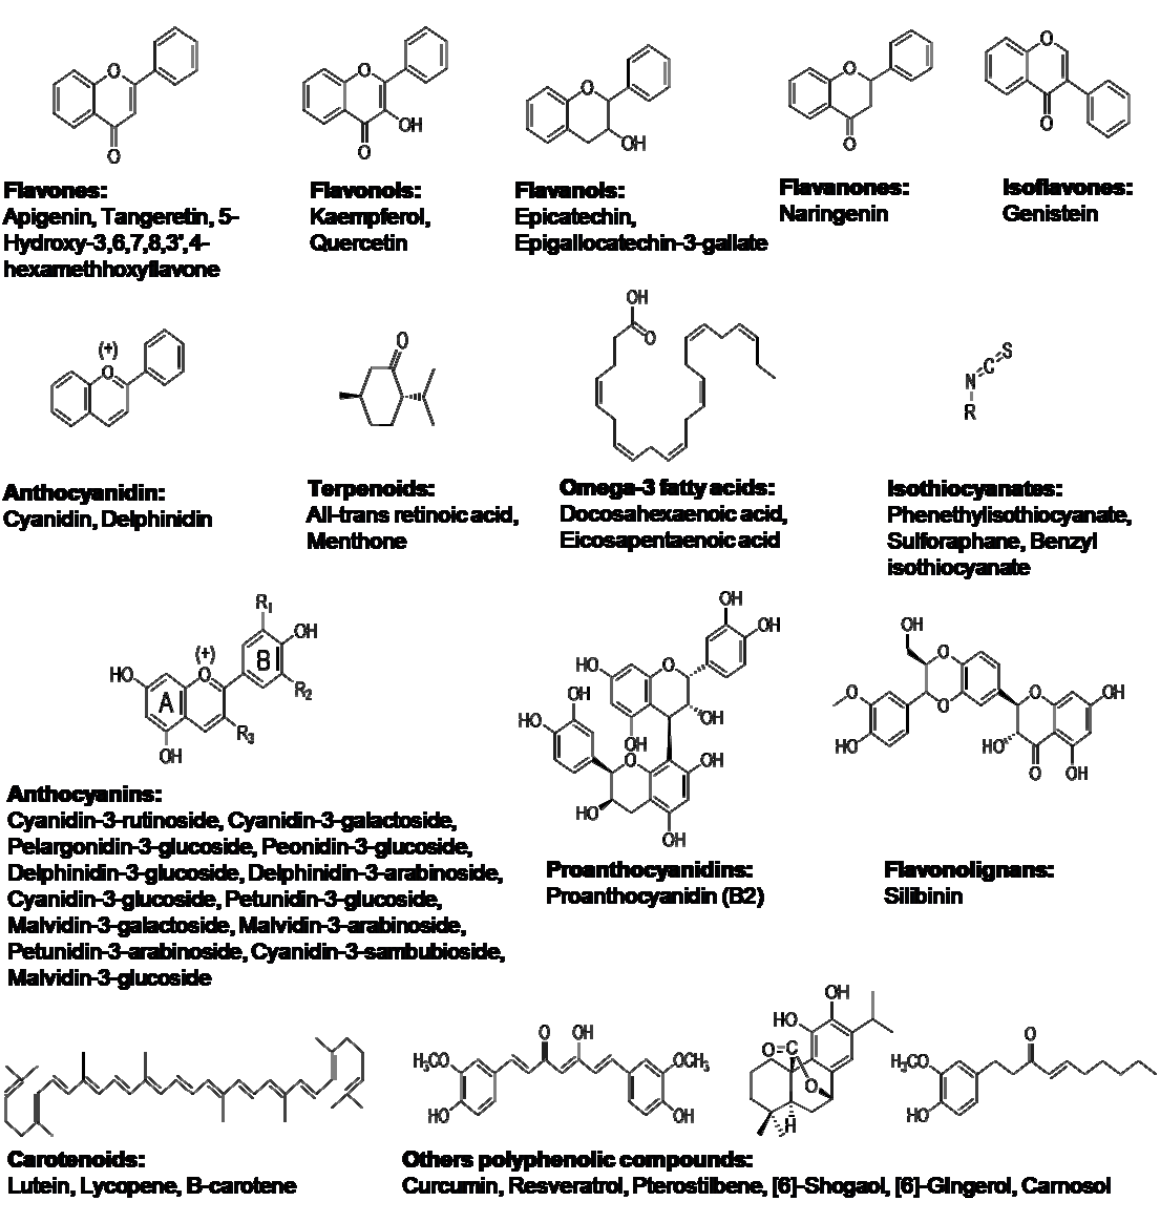
Figure 4. Chemical groups for food-related natural compounds used to perform docking studies on